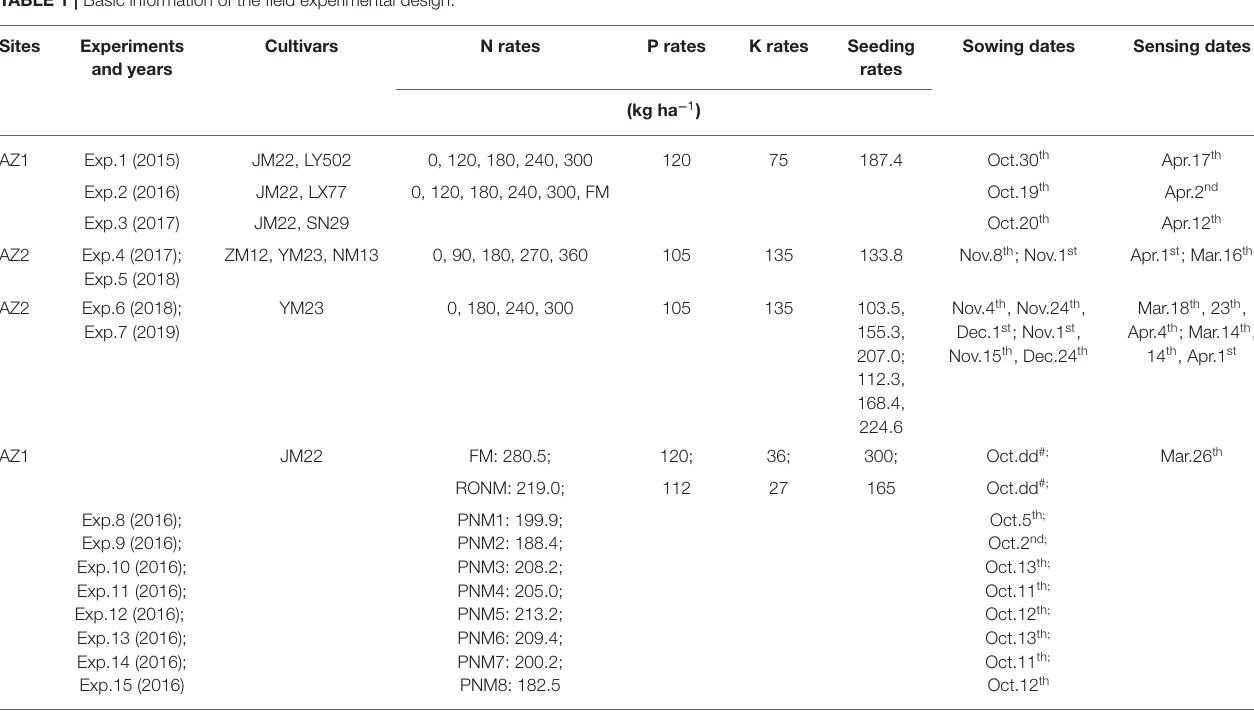
TABLE 1 | Basic information of the field experimental